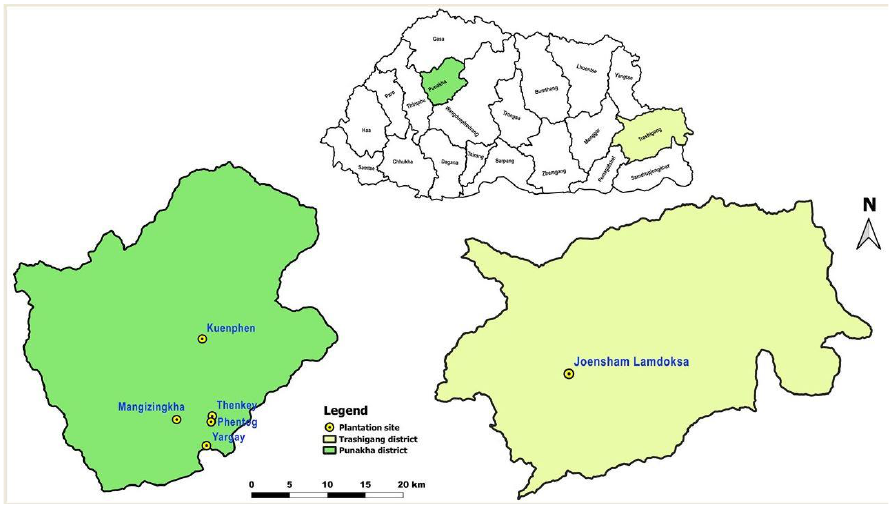
Figure 1. Location of the planted forests studied in Punakha (green) and Trashigang (yellow) dzongkhags , Bhutan. (Map created Jigme Wangchuk, 2019). Bhutan. (Map created Jigme Wangchuk,